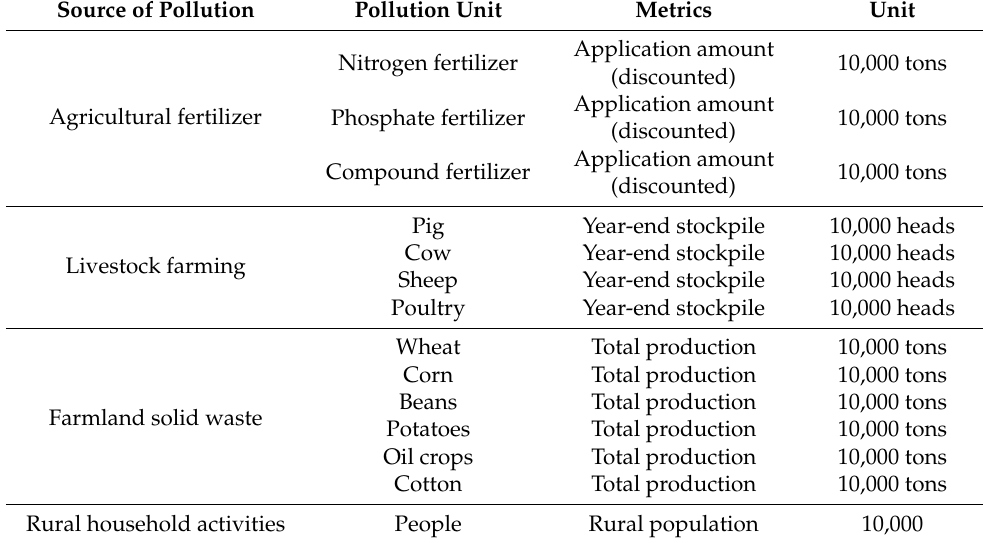
Table 1. List of ANSP in Gongyi